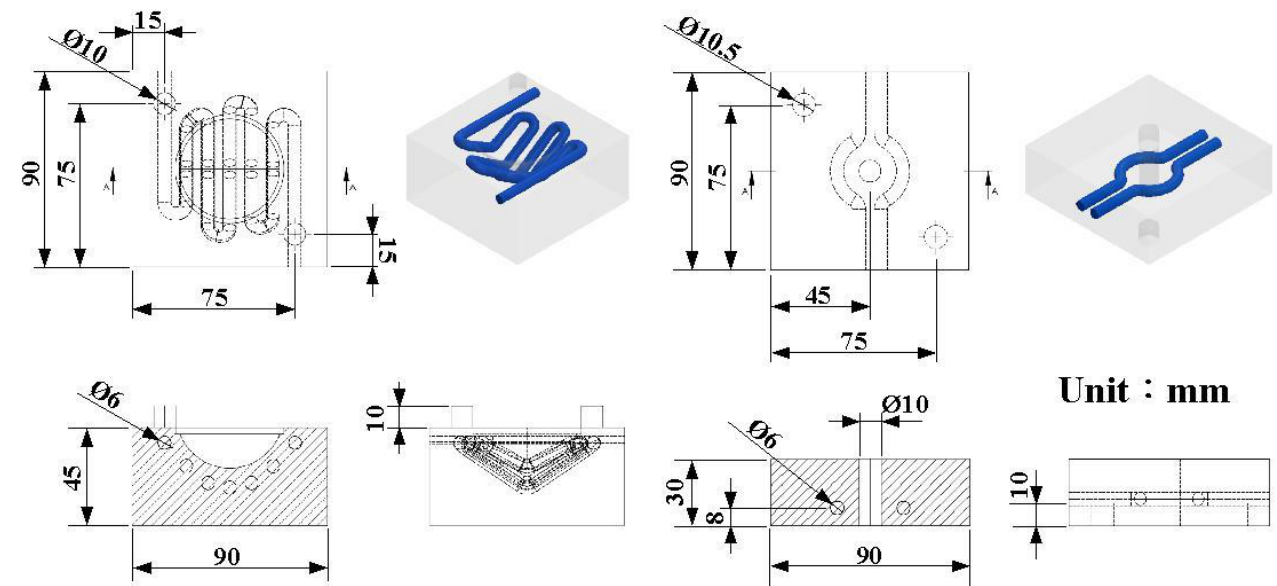
Figure 3. Three-dimensional CAD model and dimensions of cavity with CHC and core with CCC.